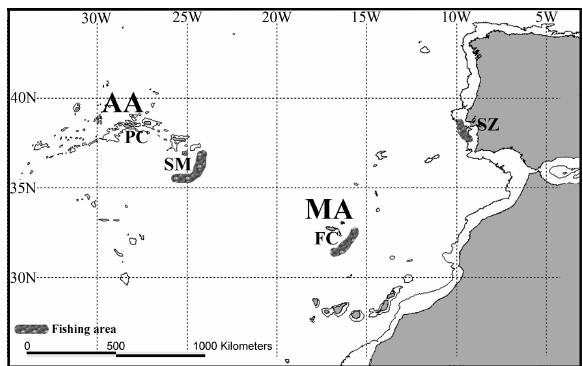
Fig . 1. – Map of the southern northeast atlantic with the sampling locations of black scabbardfish and the 1000 m isobath. aa, azores archipelago; FC, Funchal; Ma, Madeira archipelago; pC, pico is- land; sM, santa Maria island; sZ, sesimbra (mainland